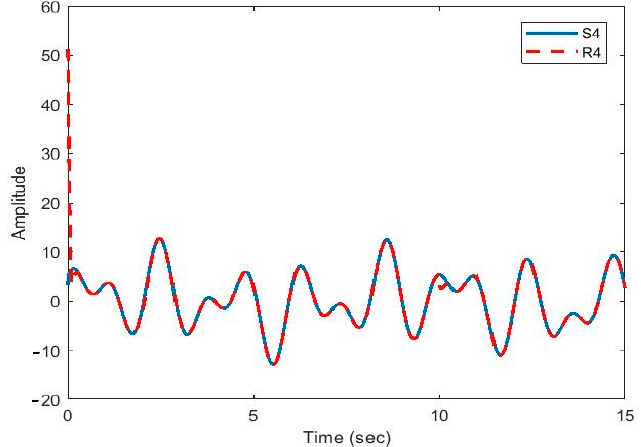
Figure 12. Plot of original signal (S (cid:2872) ) and recovered signal (R (cid:2872) ) obtained using multi-state syn- chronization and chaotic masking.